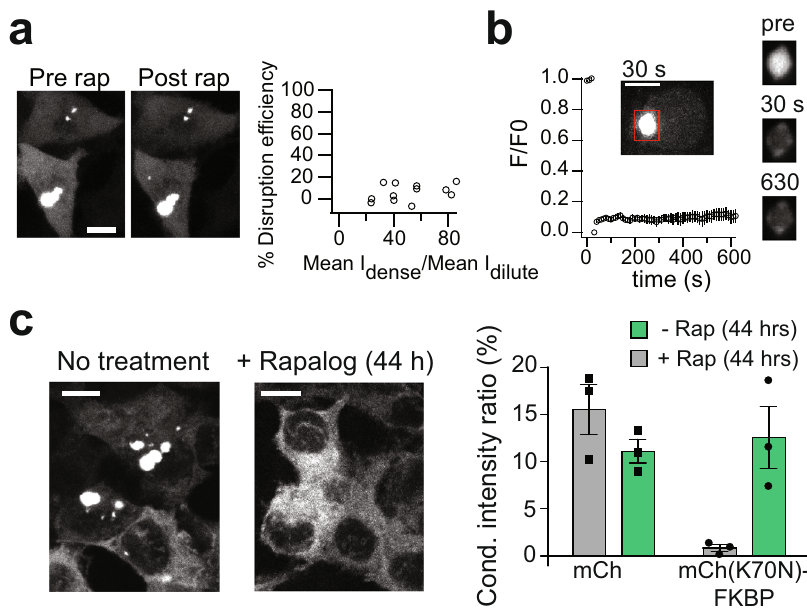
Fig. 3 HTT exon 1 condensates can be prevented from formation using DisCo but existing condensates are not disrupted. a Representative images (left) and quanti fi cation of % disruption ef fi ciency as a function of the initial EGFP mean signal in the dense phase normalized to the EGFP mean signal at the dilute phase ((Mean I dense )/(Mean I dilute )) (right) of HEK293T cells coexpressing HTTQ72-FRB-EGFP and mCh(K70N)-FKBP as C-BLOCK, exposed to 333 nM rapamycin. The experiment was repeated 3 times with similar results. Scale bars, 10 µ m. b FRAP experiments showing Q72HTT-FRB-EGFP condensates do not recover from photobleaching within 600 s. Data shows average and error (s.e.m., n = 8). Representative images of a photobleached condensate are shown at right. Scale bars, 10 µ m. c Preemptive recruitment of C-BLOCK to HTT prevents condensate formation. HEK293T cells coexpressing HTTQ72- FRB-EGFP and mCh(K70N)-FKBP were treated for 44 h with 500 nM AP21967 rapalog. Treated cells show a reduction in HTTex1 condensates compared with untreated cells or cells not expressing C-BLOCK. Representative images are shown at left, with quanti fi cation (as in Fig. 1k) at right. Data represents average and error (s.e.m, n = 3 regions with cells examined from 3 independent experiments). Scale bars, 10 µ